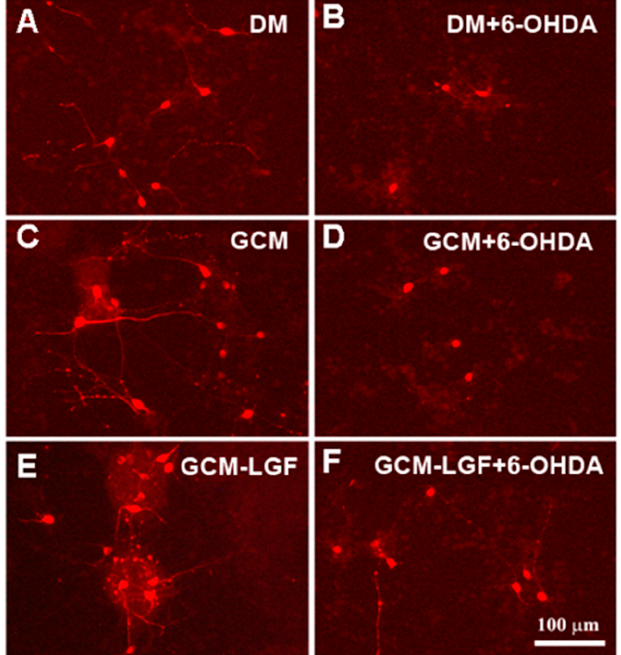
Figure 9. E ff ects of GCM-LGF on the morphology of midbrain dopaminergic neurons in culture. ( A – F ) show the e ff ects of treatment with GCM and GCM-LGF on TH-positive midbrain neurons in culture. Note how GCM-LGF partially prevented the loss of neuritic extensions of TH-positive cells induced by 6-OHDA ( F ). Scale bar 100 μ m.